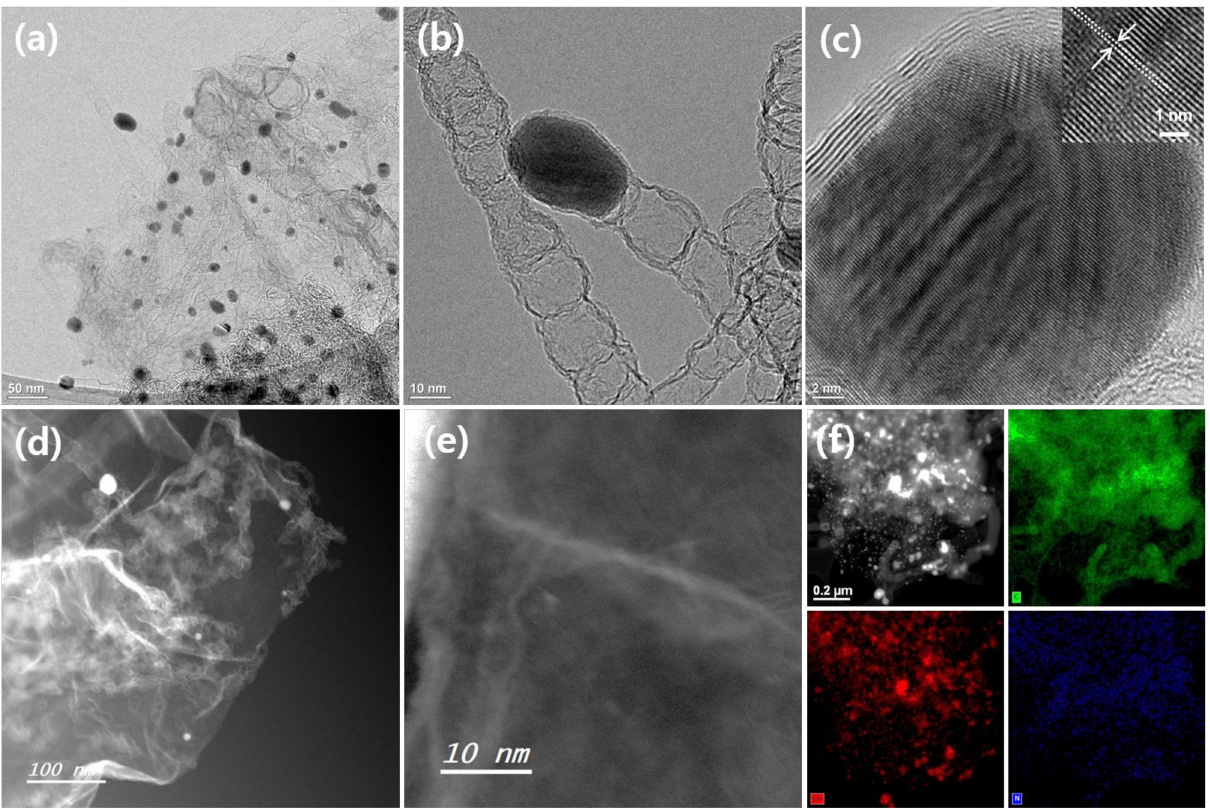
Figure 3. ( a , b ) TEM, ( c ) HR-TEM, ( d ) STEM, and ( e ) atomic-scale HAADF-STEM images, ( f ) STEM and corresponding C, Co, N elemental mapping images of